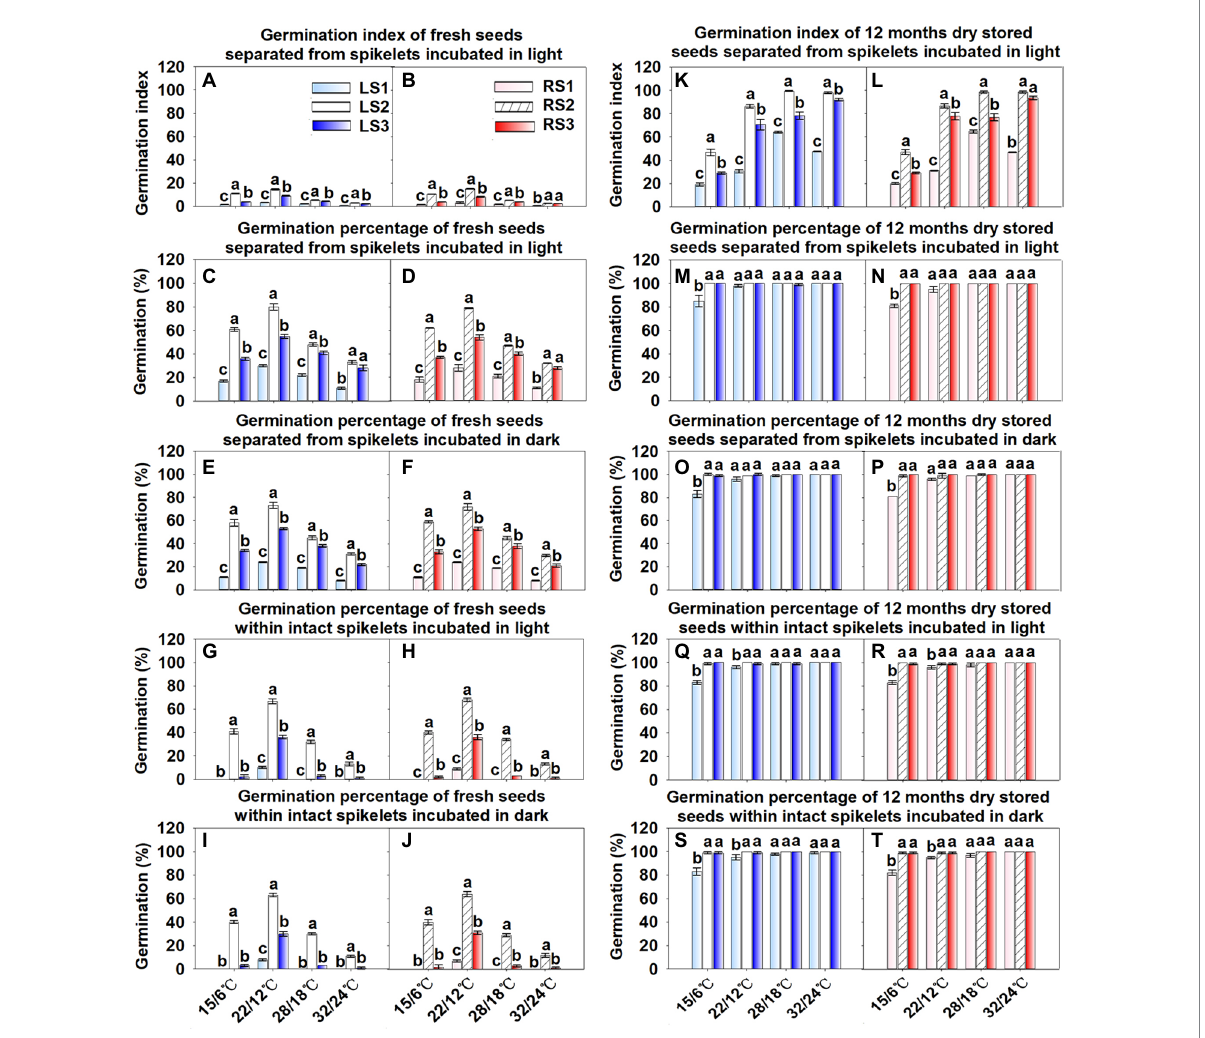
FIGURE 5 Germination percentages and germination index of fresh (o months storage; A–J ), and of 12 months dry—stored (K–T) seeds of the three seed groups. LS, seeds in spikelet type Left; RS, seeds in spikelet type Right; numbers 1, 2 and 3 following abbreviations indicate different seed groups; seed groups within a temperature of a storage category with different letters are significantly different (Tukey’s HSD, p =